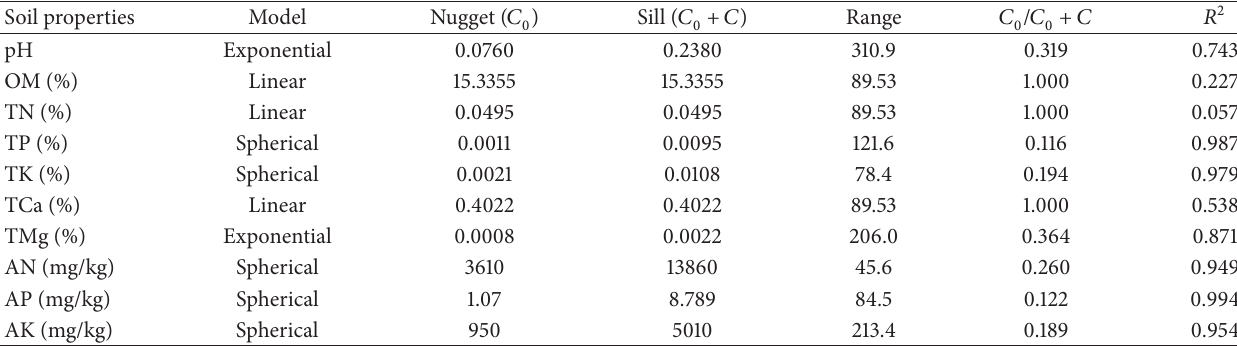
Table 2: Fitted model types and parameters for the semivariograms of soil chemical